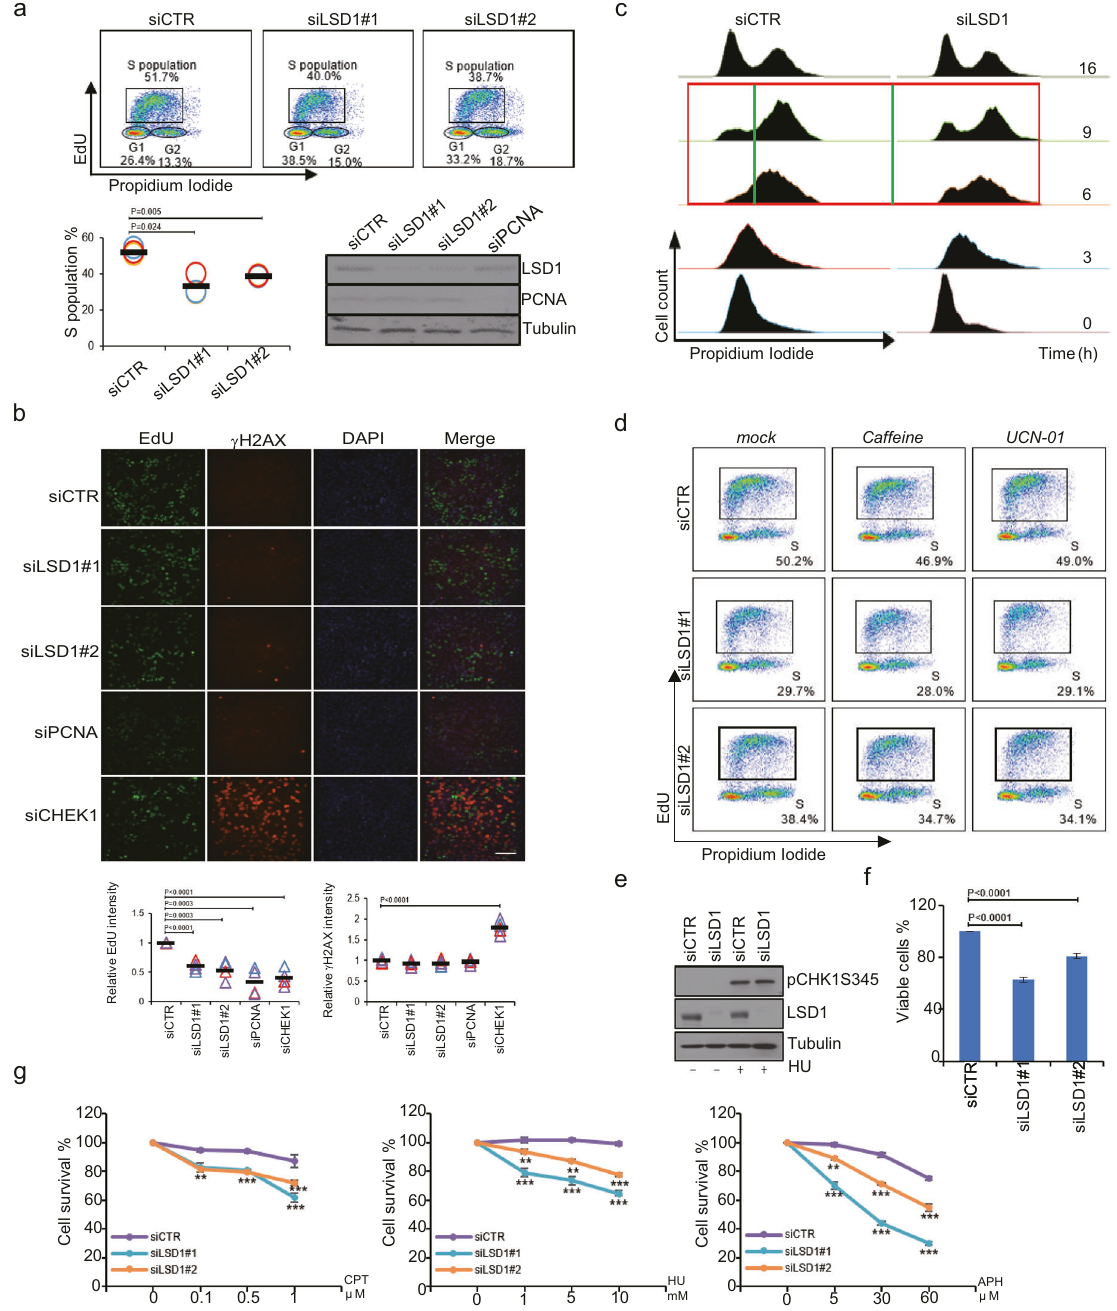
Fig. 3 LSD1 is required for DNA replication. a LSD1-de fi cient U2OS cells were subjected to EdU incorporation analysis. The percentage of cells in each phase of the cell cycle was determined by dual PI/EdU fl ow cytometry (top), and the percentage of S-phase cells is plotted. Each bar represents mean ± SD for three independent experiments. The ef fi ciency of knockdown was veri fi ed by western blotting with PCNA as a control. b LSD1-de fi cient U2OS cells were subjected to immuno fl uorescent staining for EdU and γ H2AX. Cells depleted of PCNA and CHEK1 were used as positive controls for replication defects and spontaneous DNA damage, respectively, and the immuno fl uorescent signal of EdU and γ H2AX was quantitated. Each bar represents mean ± SD for three independent experiments. Scale bar, 200 μ m. c LSD1-de fi cient U2OS cells were synchronized at the G 1 /S transition by double-thymidine block, released for different times, and analyzed for DNA content by fl ow cytometry. d LSD1-de fi cient U2OS cells were treated with caffeine or UCN-01 for EdU incorporation analysis. e Western blotting analysis of pCHK1S345 in HeLa cells depleted of LSD1. f LSD1-de fi cient U2OS cells were subjected to cell viability assays. Each bar represents the mean ± SD for three independent experiments. g LSD1-de fi cient U2OS cells were challenged with different doses of CPT, HU, or APH for cell viability assays. Each point represents the mean ± SD for three independent experiments (** p < 0.01, *** p < 0.001; t